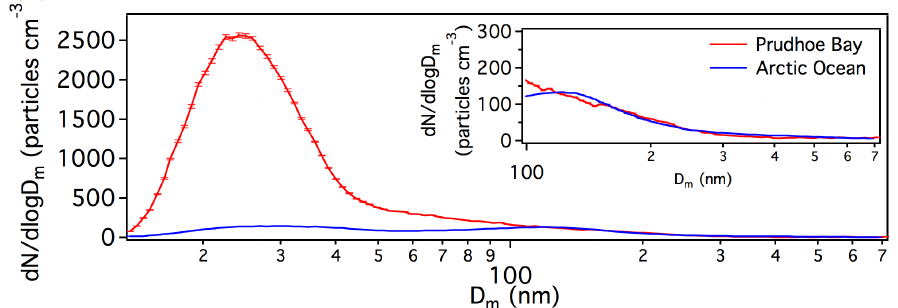
Figure 2. Average and standard error of the mean particle number size (14–746nm mobility diameter) distributions during air masses influenced by Prudhoe Bay and the Arctic Ocean from 21 August to 20 September 2015, with the above-100nm distributions inset. The full time series of the time-varying aerosol distribution is shown in Fig.